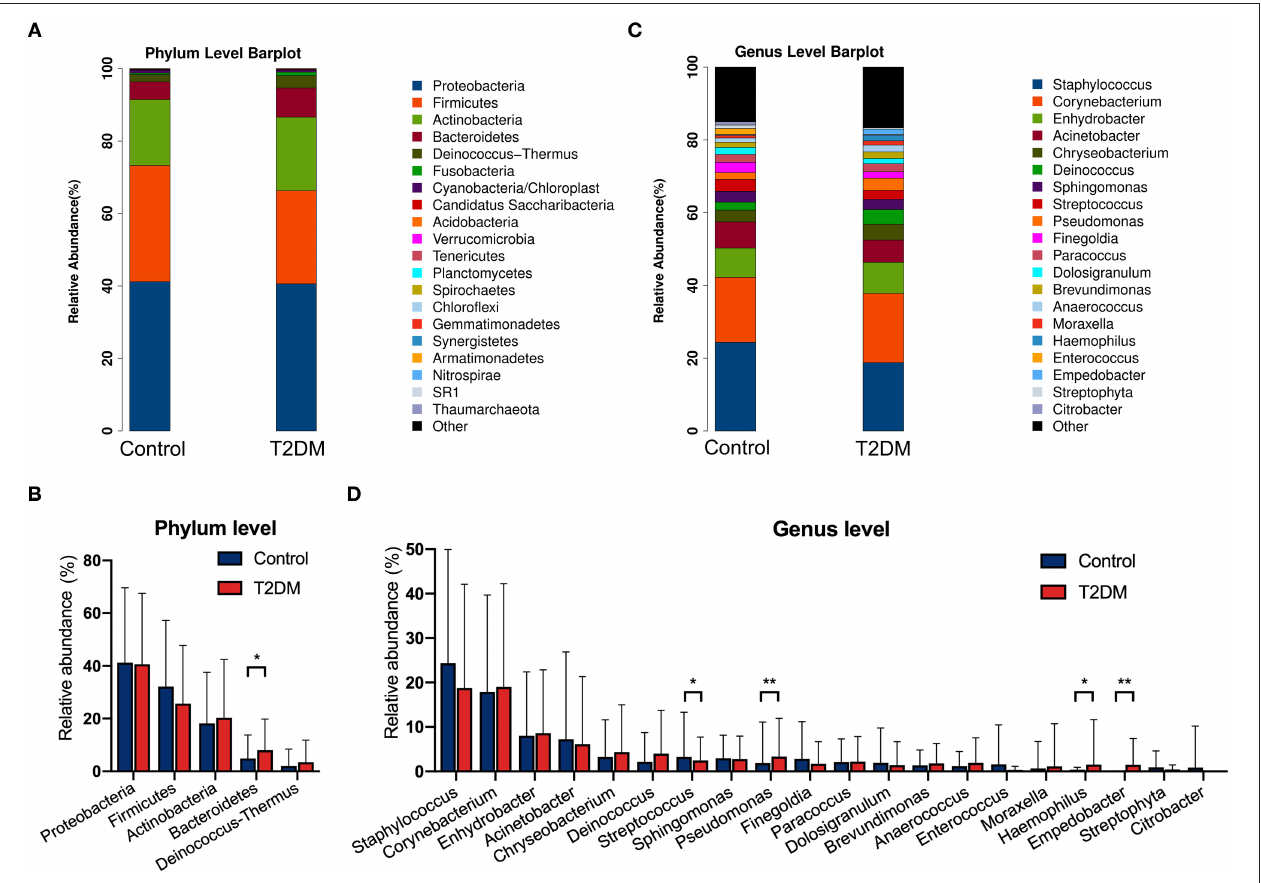
FIGURE 2 | The relative abundances of conjunctival microbiota in the control group and in T2DM group. (A) The relative abundance at the phylum level. (B) Comparisons of the top 5 phyla between the control group and T2DM group (113 vs. 79 samples). (C) The relative abundance at the genus level. (D) Comparisons of the top 20 genera between the control group and T2DM group (113 vs. 79 samples). Wilcoxon signed-rank test was used. * P < 0.05; ** P < 0.01.